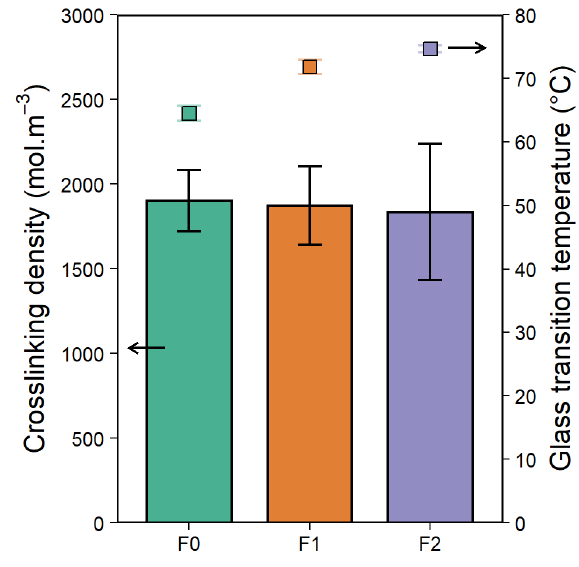
Figure 4. Crosslinking density and glass transition temperature of the coatings.